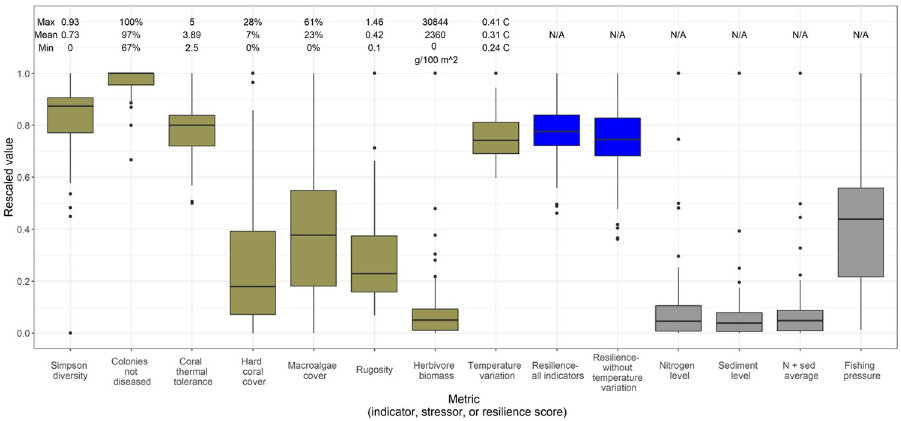
Fig 1. Rescaled indicators, unweighted resilience scores, and stressors for 103 reef survey sites around Puerto Rico. Indicators have the raw minimum and maximum values found at all 103 sites above their boxplots; numbers without units are unitless indicators. Resilience scores and stressors do not have raw minimum and maximum values because they are calculated relative to the maximum at the surveyed sites. Brown bars are resilience indicators, blue bars are resilience scores, and grays bars are